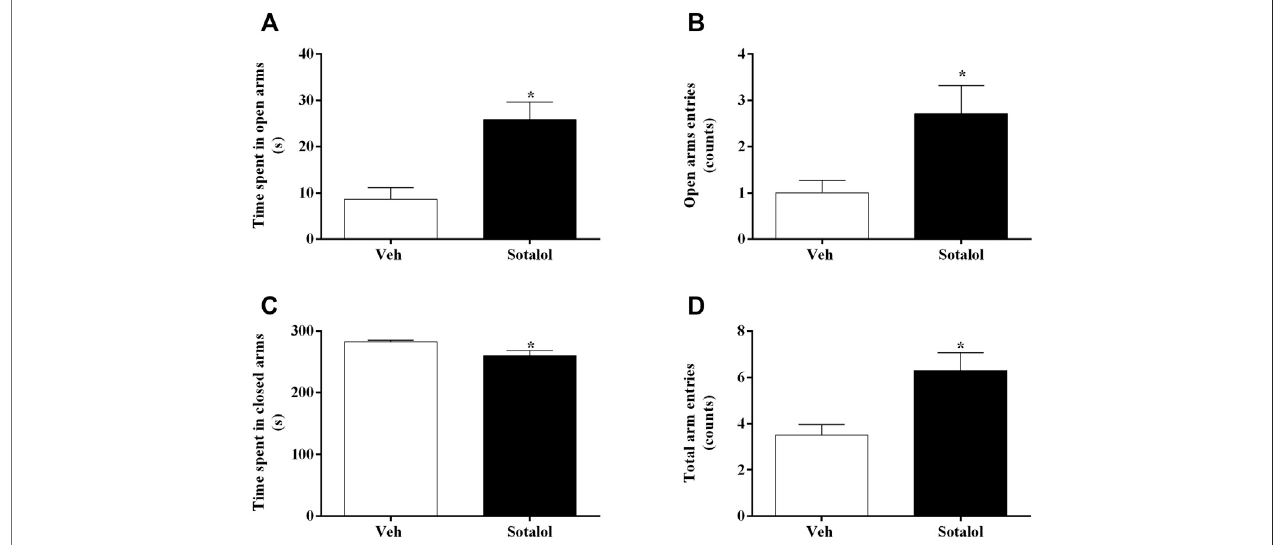
FIGURE 3 | (A) Time spent in open arms, (B) open arm entries, (C) time spent in closed arms, and (D) total arm entries of the elevated plus-maze test (EPMT), on day 15 after post-traumatic stress disorder (PTSD) induction. Veh, vehicle-treated PTSD mice; Sotalol, sotalol-treatedPTSD mice.Values are means ± SEM of 6-7mice per group. *, signi fi cantly different from correspondent values in vehicle-treated PTSD mice ( p ˂ 0.05).